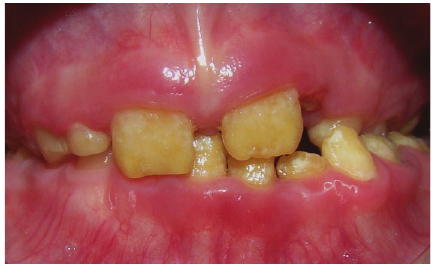
Figure 2: Initial intraoral view showing the teeth with AI.